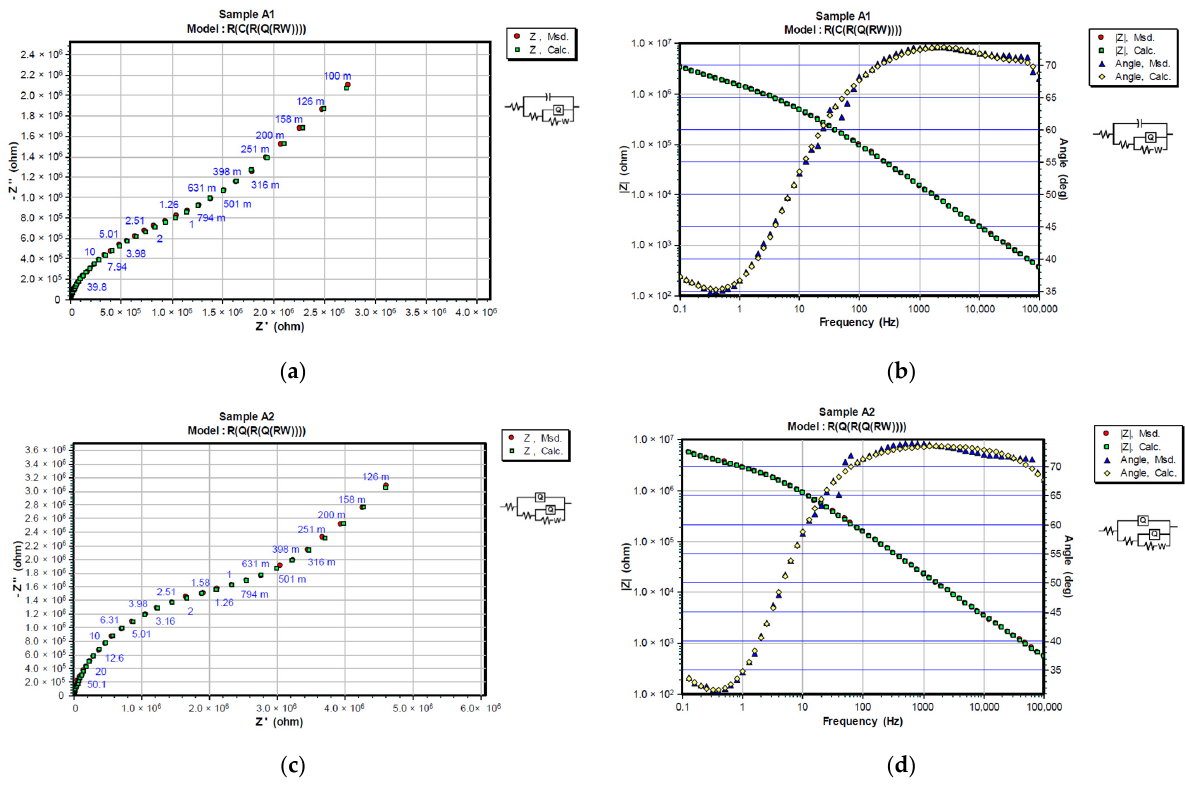
Table 7. Fitted values of equivalent circuit elements (R s , C C /Q c , R c , C dl /Q dl , R ct, W) and the corre- sponding chi-square value ( χ 2 ) after 24 h in 3% NaCl.